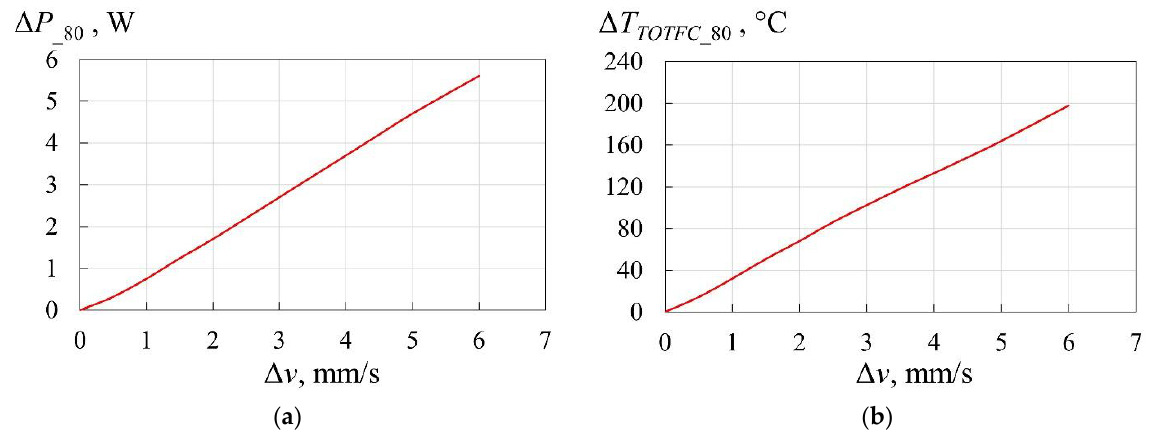
Figure 6. The dependences of ∆ P _80 ( a ) and ∆ T TOTFC _80 ( b ) on the step of change in the traction speed TOTFC ∆ ν , provided that the temperature of the vein wall is 80 ◦ C (the wavelength of laser radiation is 980 nm, the inner vein diameter is 5 mm).